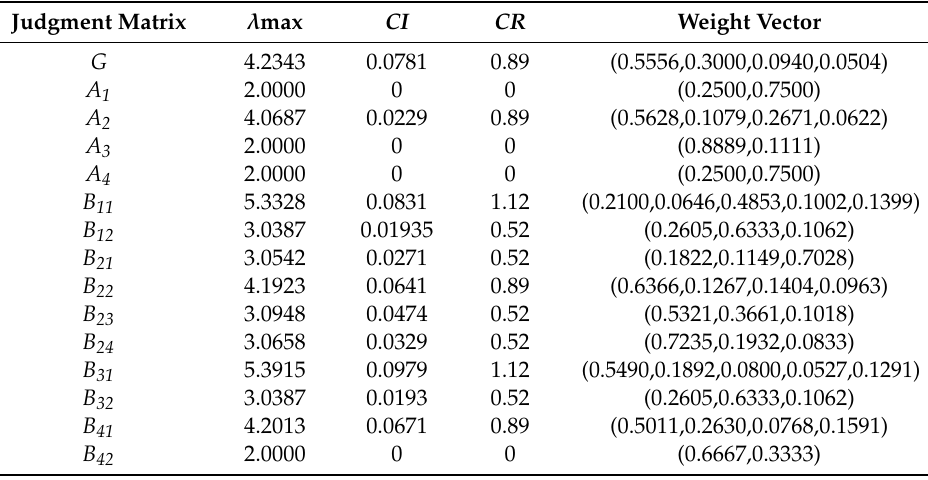
Table 5. Judgment matrix consistency and index weight